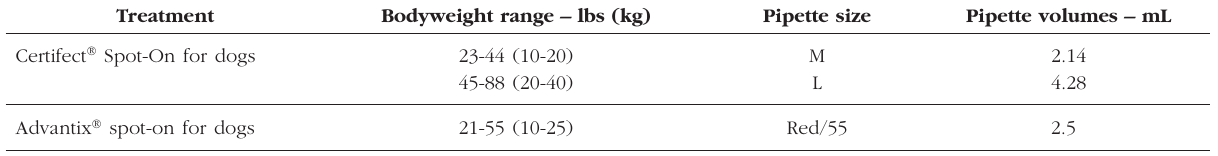
Table I. – Dosage of dogs in the treated groups.